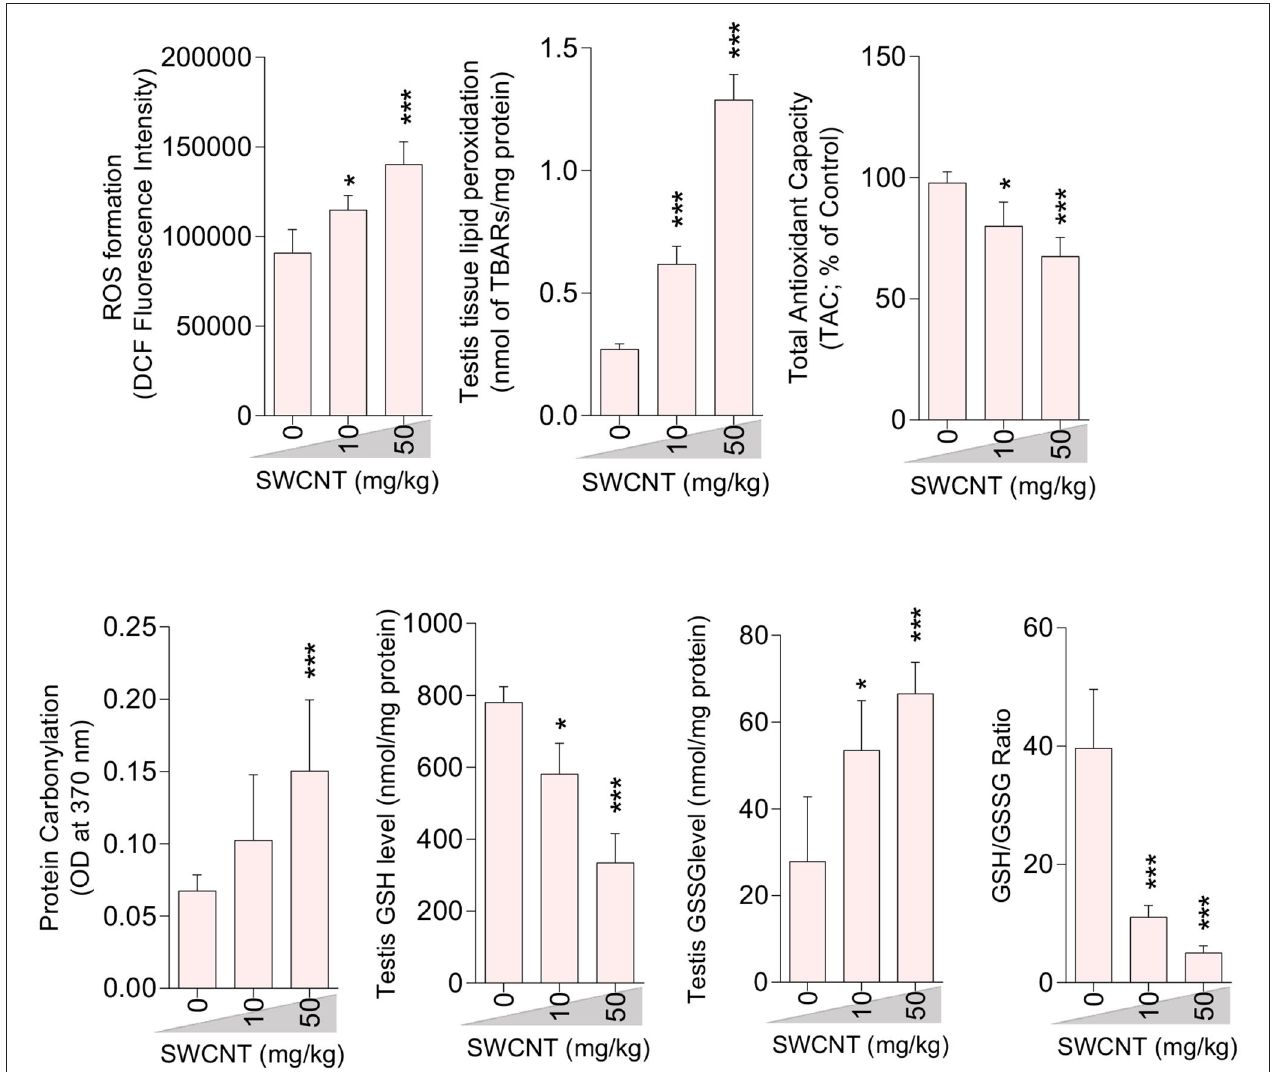
FIGURE 5 | Effect of single-walled carbon nanotubes (SWCNT) on oxidative stress parameters in the testis of mice (mean ± SEM, n = 6). Asterisks indicate significantly different from the control (0 ppm) group (* P < 0.05, *** P < 0.001).